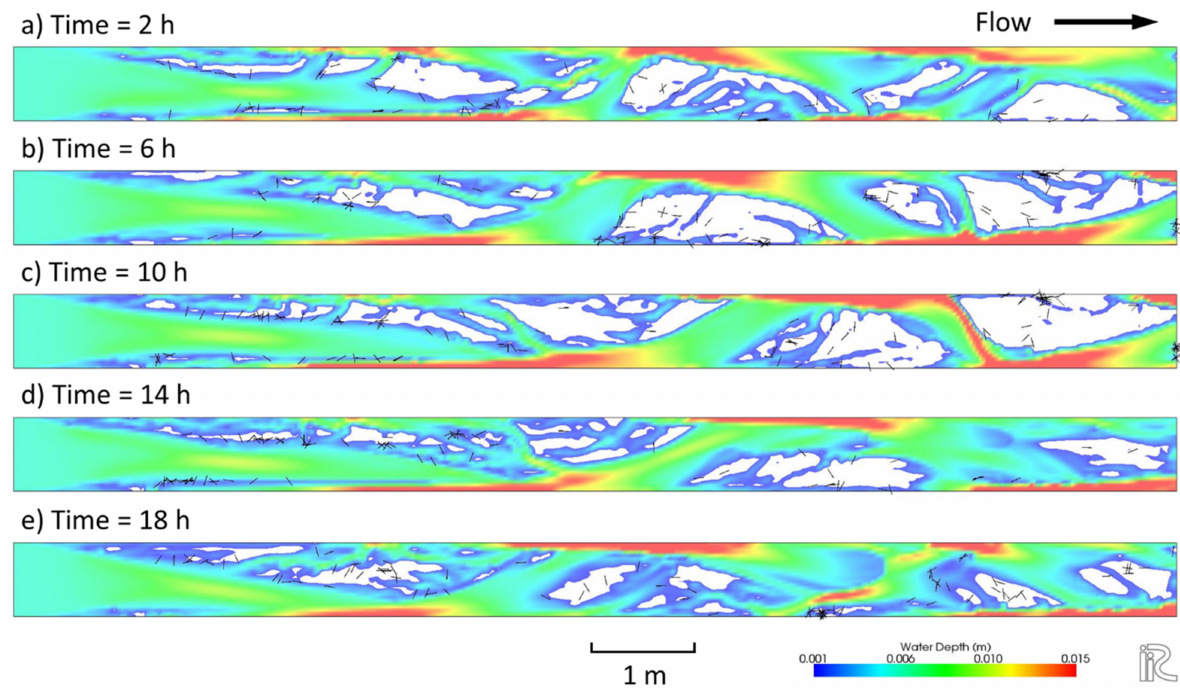
Figure 6. Calculation results for channel pattern and depositional distribution of wood pieces in Case 2. ( a – e ) temporal changes during the latter 18 h calculated for channel, and depositional patterns of wood piece. Solid black lines denote wood pieces. The length and diameter of wood pieces are increased by factor of 3 and 5 for visualization, respectively.